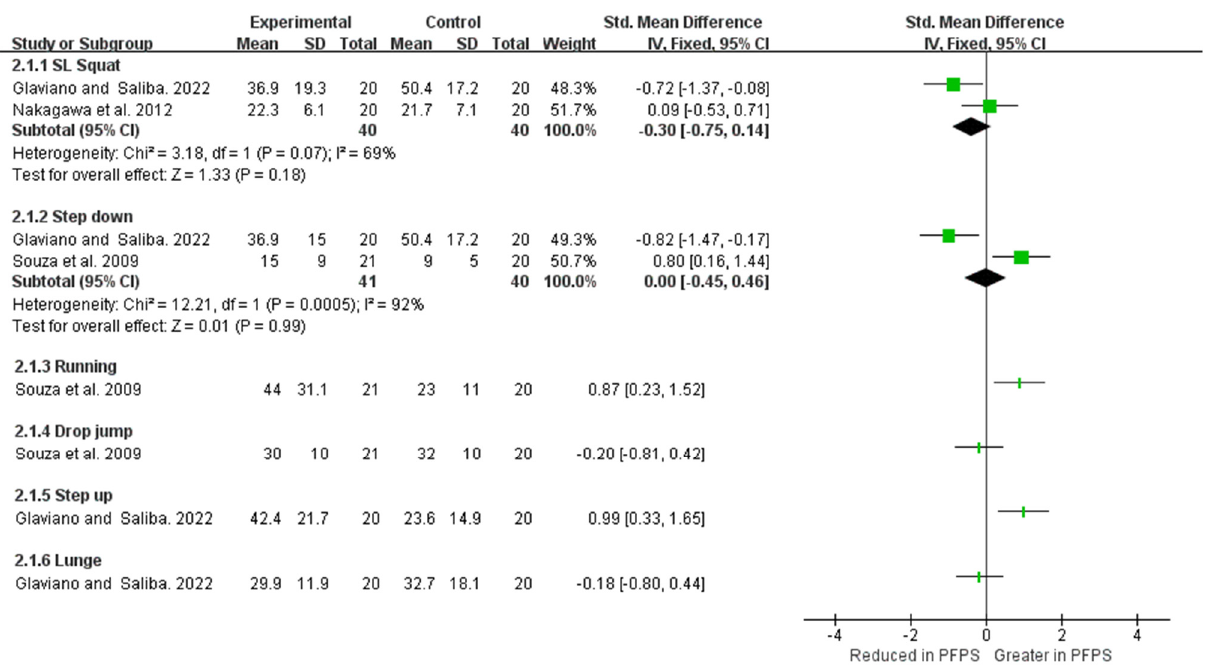
Figure 10. GMed activation among the functional activities [15,18,25].